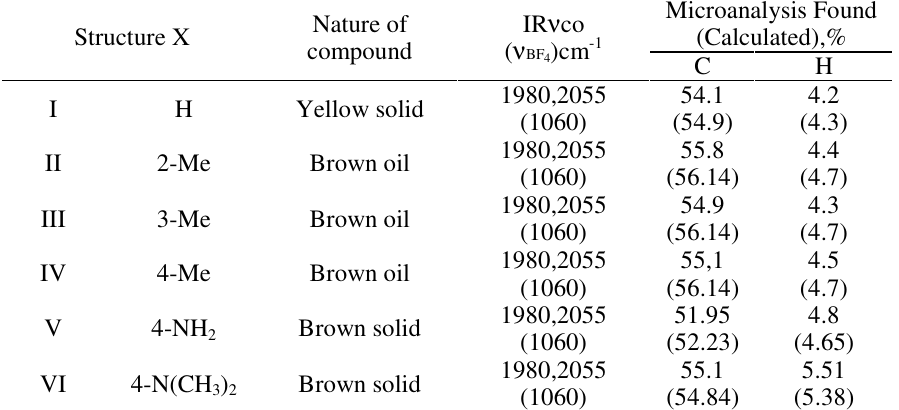
Table 2. Nature of compound, infra-red spectra data and micro analytical data for the